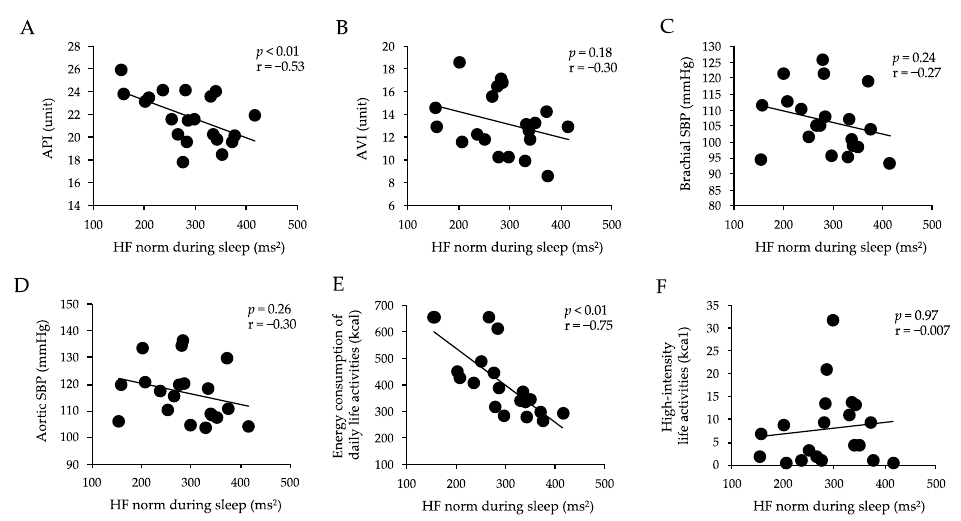
Figure 5. Correlations between API ( A ), AVI ( B ), brachial SBP ( C ), aortic SBP ( D ), energy consumption of daily life activities ( E ), high-intensity life activities ( F ), and HF norm during sleep. HF, high-frequency; API, arterial pressure-volume index; AVI, arterial velocity pulse index; SBP, systolic blood pressure. Values are mean ± SD.